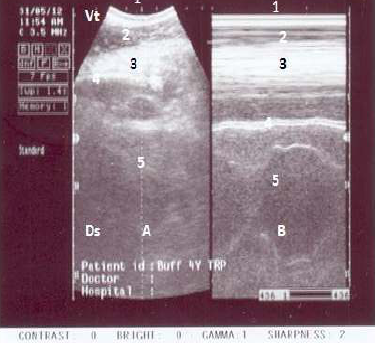
Figure-14. Ultrasonogram using the B mode (A) and BM mode (B) on 4-year-old buffalo suffered from TRP. The transducer was applied at the left parasternal region showing hyperechoic deposits between the abdominal and reticulum wall suggestive fibrin deposit and adhesion (3). Skin (1), abdominal wall (2), adhesion (3), reticular wall (4) and reticulum (5).